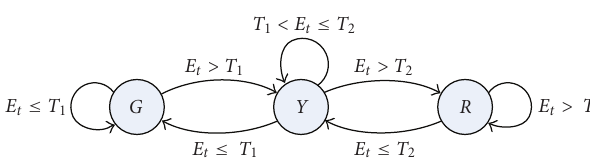
Figure 2: State transition diagram of the adaptive channel